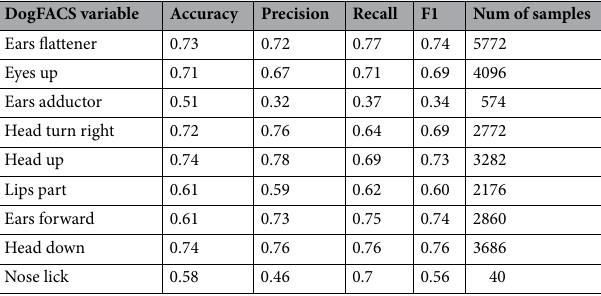
Table 4. DogFACS variable detector performance.